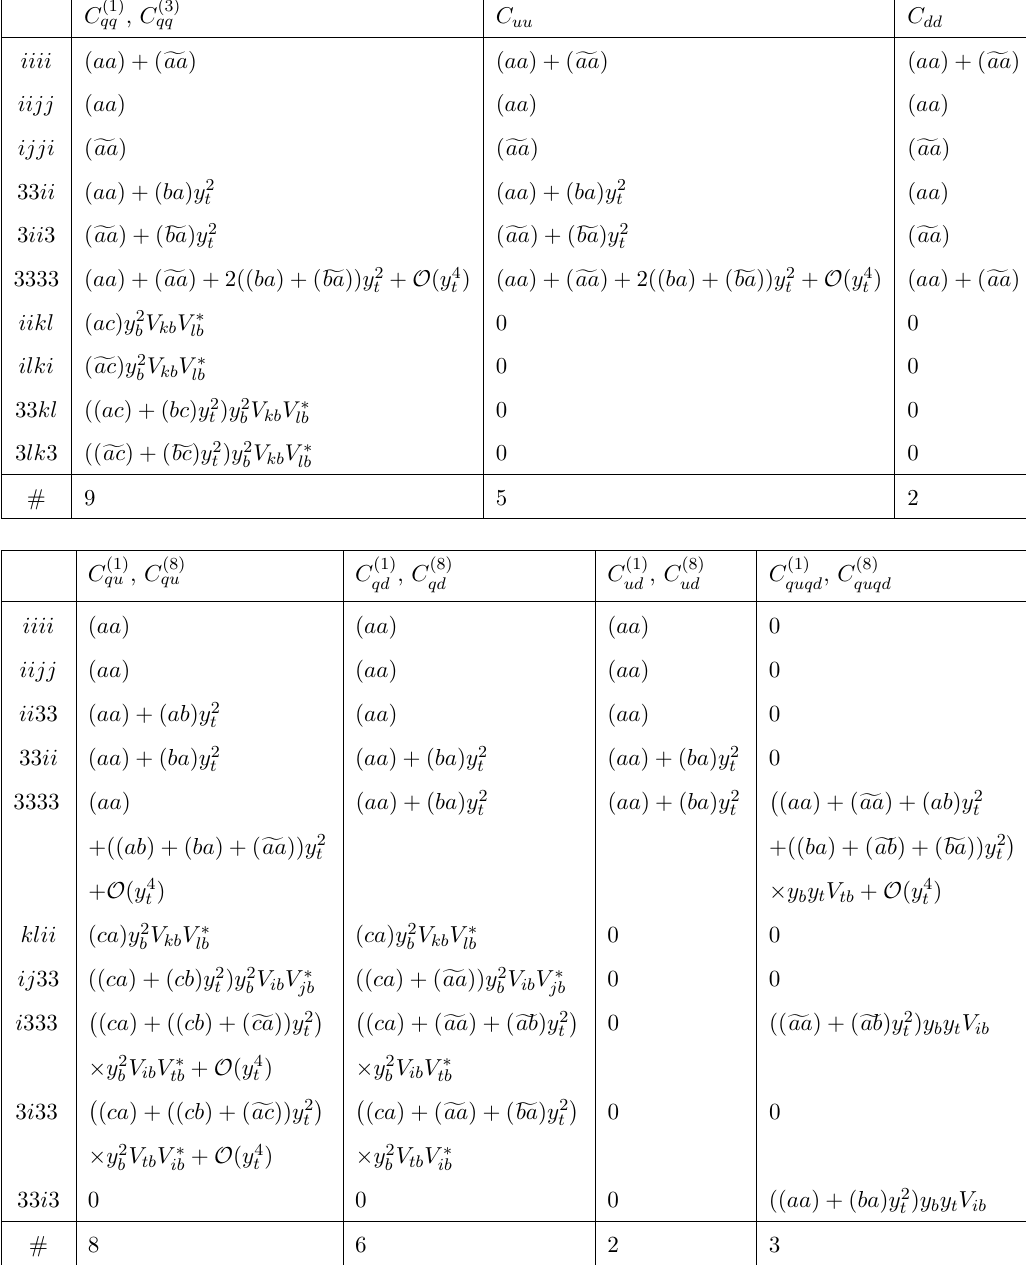
Table 2 . Wilson coefficients of four-quark SMEFT operators in MFV with up-alignment. The flavor indices are i, j ∈ { 1 , 2 } with i 6 = j and k, l ∈ { 1 , 2 , 3 } with k 6 = l 6 = i . Subleading contributions in y b and contributions of O ( y ) or smaller have been neglected. Terms of O ( y 4 ) are indicated where they c t introduce additional flavor parameters. The last line of each table shows the number of independent flavor degrees of freedom in the Wilson coefficients up to O ( y 2 ) . The Wilson coefficients for all other b combinations of flavor indices vanish in our